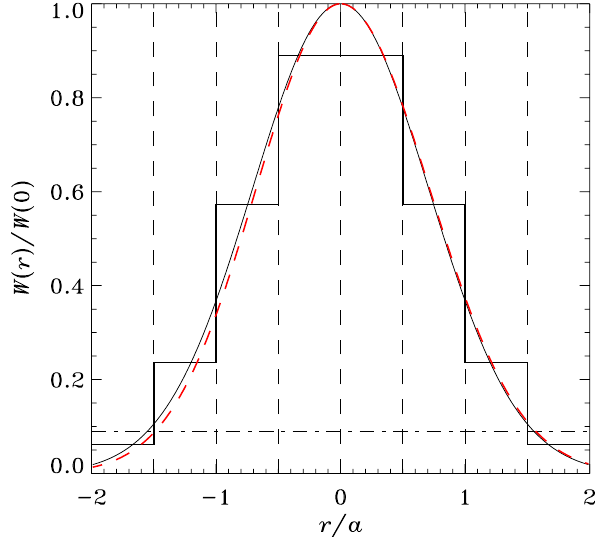
Fig. 2. Distribution of the normalized pump power inside of the heated cone versus the normalized distance from the center for two cases: (i) projection of the heated cone on the horizontal plane at the altitude 230km is considered as a perfect circle with the radius a=30km (solid line), (ii) the radius of the heated spot varies from 28.8 to 30.3km (dashed line). W( 0 ) is the power in center. Verti- cal lines mark the limits of the gates, horizontal lines represent the average power inside of each gate and dashed-dotted line shows the estimated level of threshold